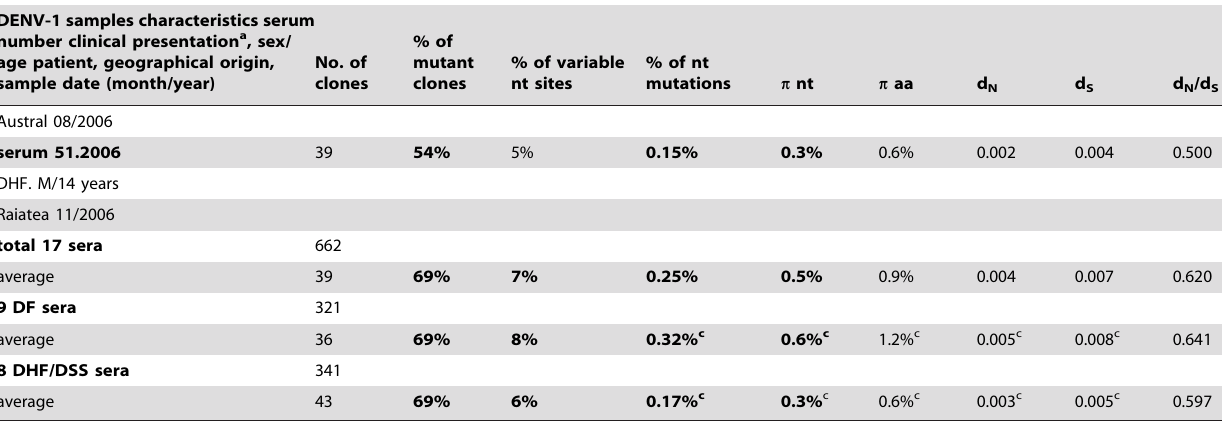
Each clone sequence was compared to other clone sequences for each serum sample. The percentage of variable nucleotide (nt) sites was the number of variable nt sites 6 100 divided by the number of nt analysed (758 nt). The percentage of nucleotide (nt) mutations was the number of nt mutations 6 100 divided by the number of nt sequenced for each serum sample. The average pairwise distance was calculated among the nucleotide ( p nt) and amino acid ( p aa) sequences in each serum. The mean ratio of non-synonymous (d N ) and synonymous (d S ) substitutions per site were estimated using the pairwise method of Nei and Gojobori. a DF=dengue fever, DHF=dengue haemorraghic fever, DSS=dengue shock syndrome. b Strains 47.2002 and 49.2002 corresponded to sequential samples from the same patient (day 1 and day 4 of the symptoms). Overall, the time of serum collection relative to infection that do not appear to be a critical parameter for the study of DENV intra-host genetic diversity [42,43] ranged from one to six days in documented cases. c Differences between DF and DHF sera were statistically significant (p , 0.05, see Methods for details of statistical analysis).